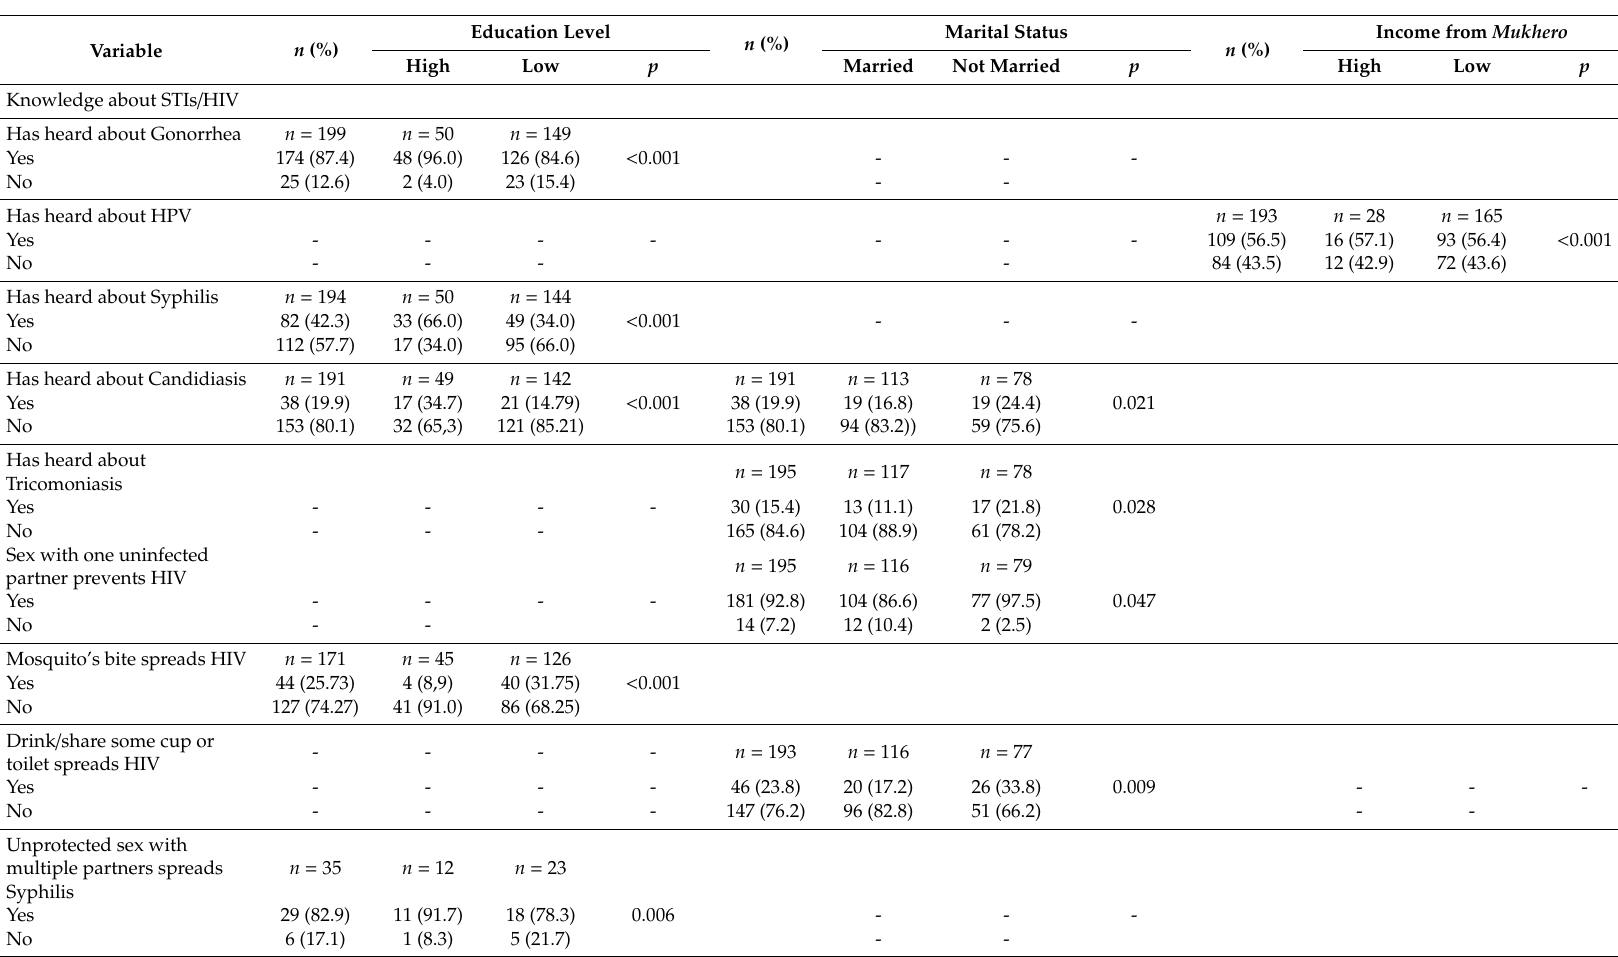
Table 6. Bivariate analysis between knowledge, risk perception, sexual behaviors about STIs / HIV and education level, marital status, and income from Mukhero .